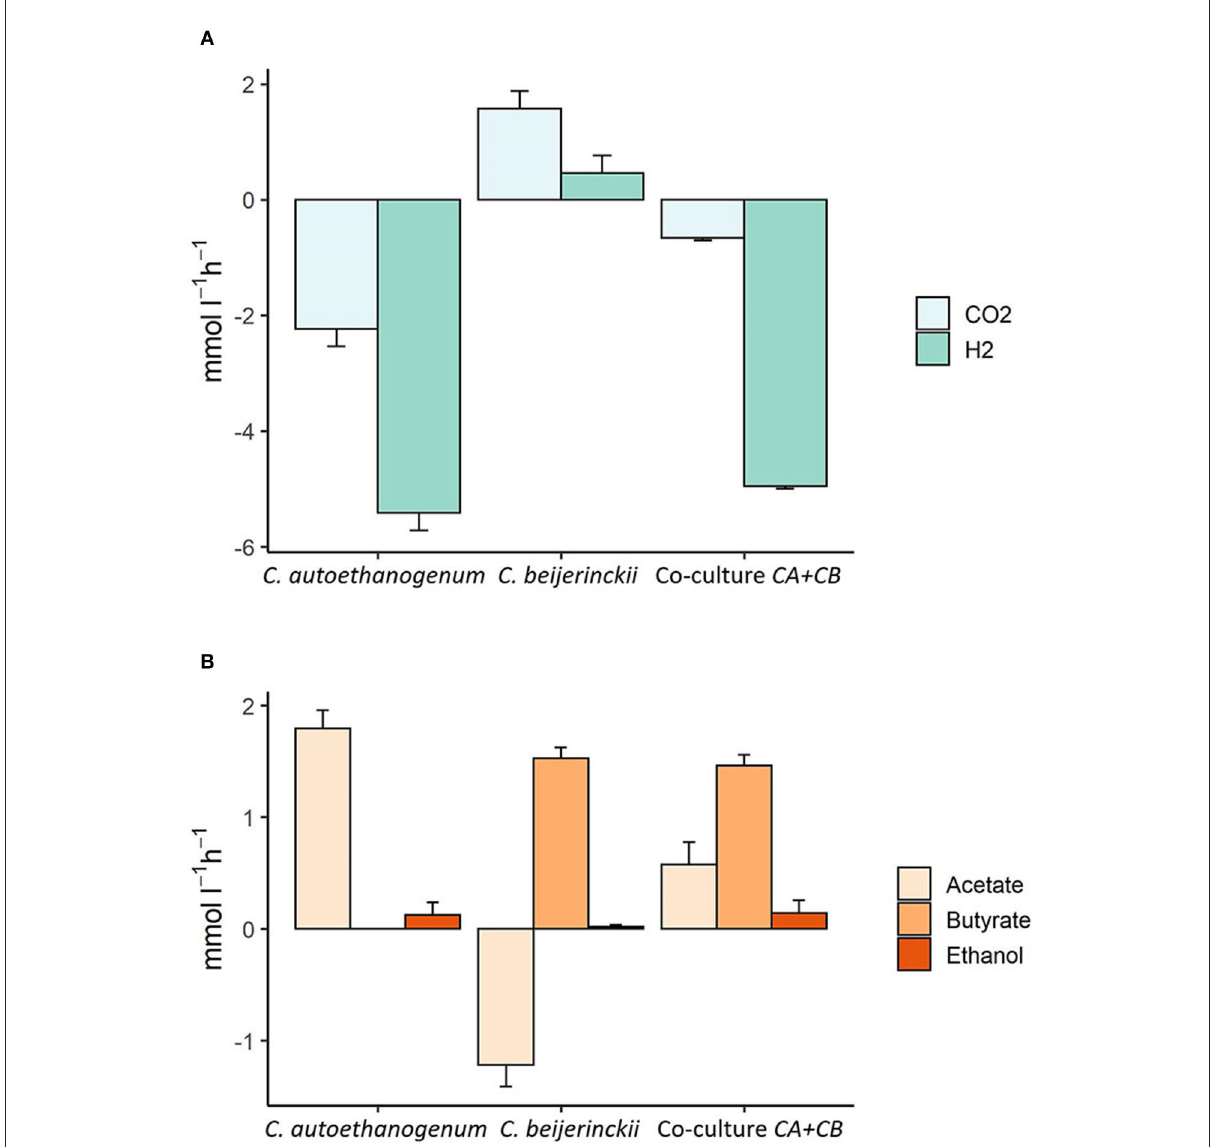
FIGURE7 Steady-state production and consumption rates of the main substrates and products predicted by the community model of C. autoethanogenum and C. beijerinckii . The x-axis shows the species associated to the illustrated fluxes. The y-axis shows uptake (negative) or production (positive) fluxes in mmol l -1 h -1 . (A) Shows CO 2 and H 2 production or consumption rates, and (B) shows the production or uptake of acetate, butyrate, and ethanol. Modeled uptake and production rates are shown for C. autoethanogenum , C. beijerinckii and for the co-culture of C. autoethanogenum and C. beijerinckii (Co-culture CA+CB ), respectively. Growth rate was set to 0.02 h -1 ; biomass species ratio was set to 1:1; maximum and minimum lactate uptake rate was set to 2.5 and 0.1 mmol l -1 h -1 , and the maximum and minimum uptake of CO 2 and H 2 were set to 5 and 0.5 mmol l -1 h -1 ,